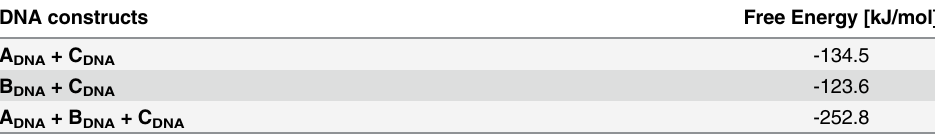
Table 2. Free energy of the secondary structures of DNA